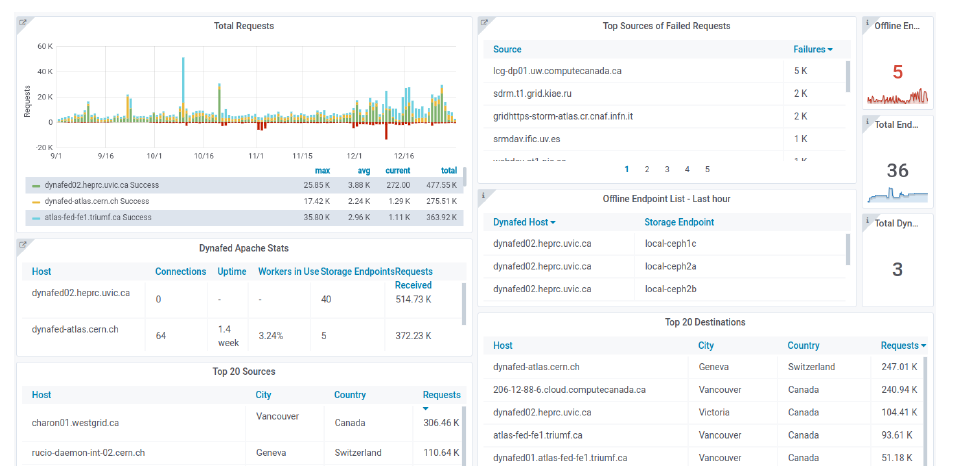
Figure 4: Overview page for our Dynafed